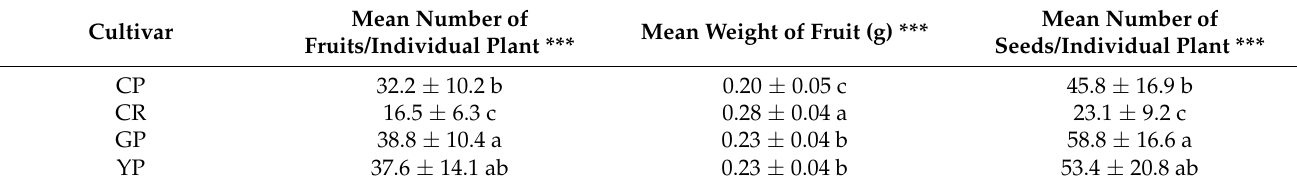
Table 1. Fruit and seed production depending on the cultivar of P. ginseng.